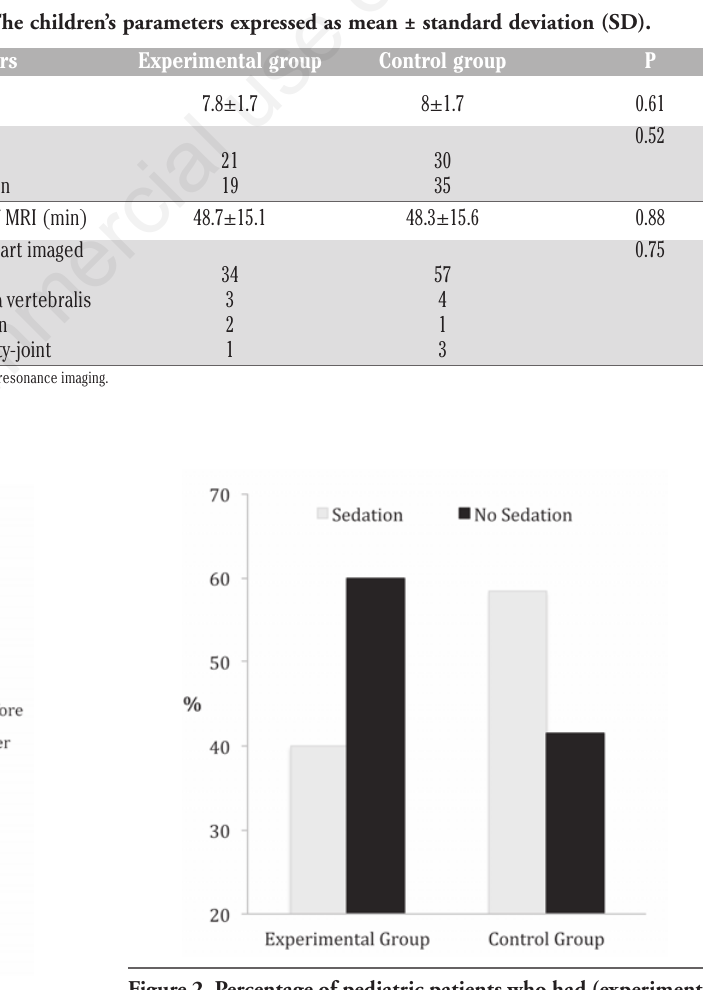
Figure 2. Percentage of pediatric patients who had (experimental group) or had not (control group) partecipated to activities. A significant (P<0.025) decreasing in the need for sedation emerged for experimental